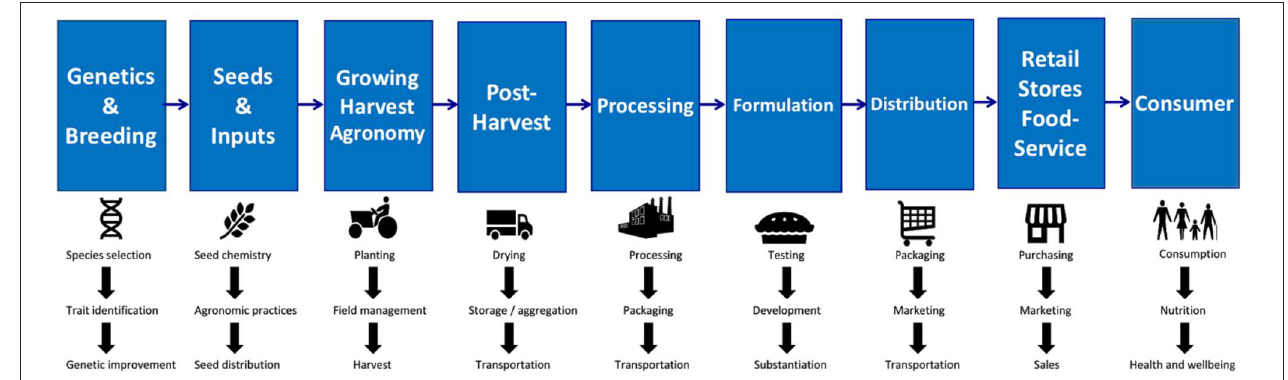
FIGURE 1 | Value chain example gives an overview of a hypothetical agricultural value chain.